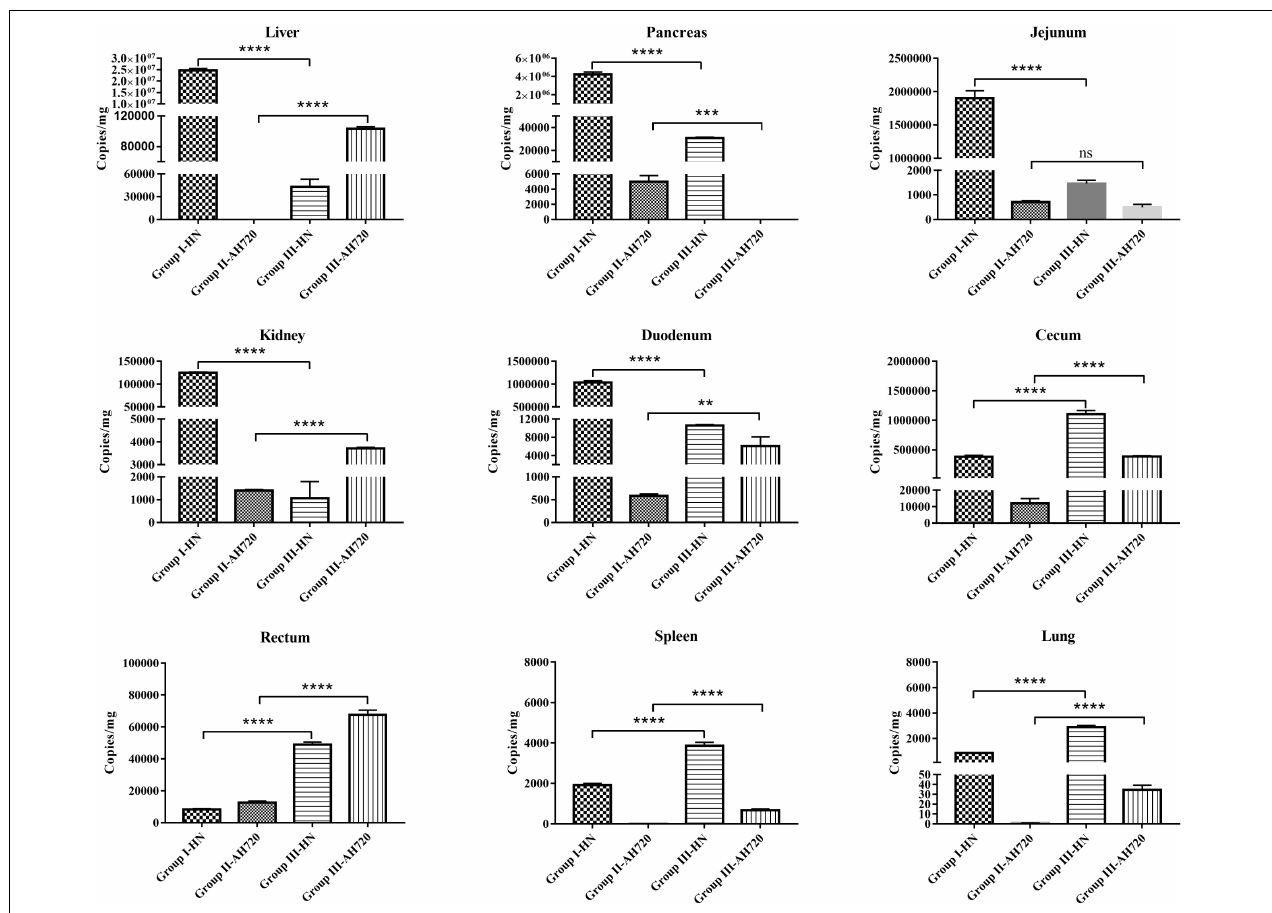
FIGURE 2 | Viral loads in different infected tissues. Tissue samples from liver, pancreas, jejunum, kidney, duodenum, cecum, rectum, spleen, and lung were collected from chickens at 3 days post-challenge. Viral DNA was detected using TaqMan quantitative real-time PCR. The error bars indicate SEM. ns represents not significant, ** P < 0.01, *** P < 0.001, **** P < 0.0001 (Student’s t